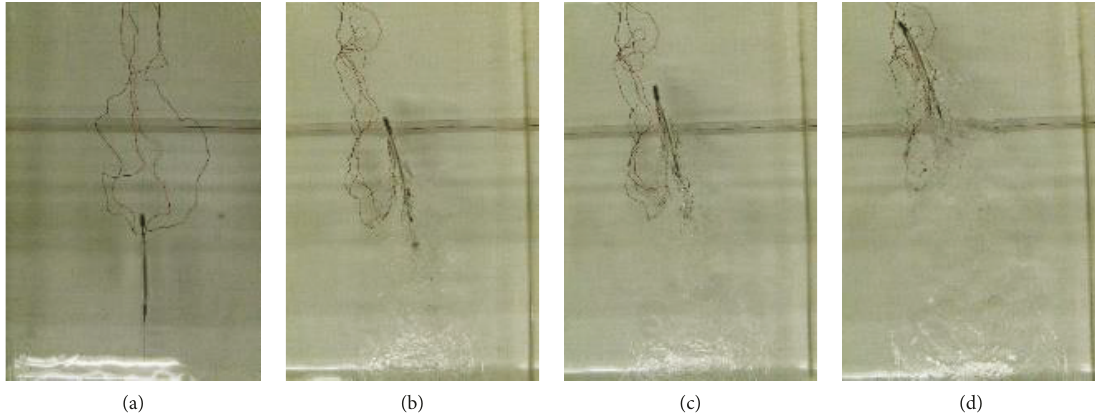
Figure 18: Turning left motion of new soft robot prototype at 15 Hz. (a) T = 0 s. (b) T = 0 3 s. (c) T = 0 4 s. (d) T = 0 6